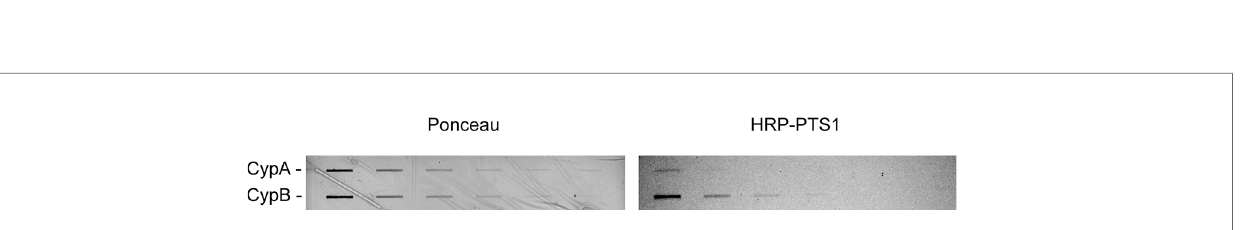
FIGURE 3 | Cyclophilin binding to PTS1. Two-fold serial dilutions of cyclophilin A (CypA) or cyclophilin B (CypB) were placed on nitrocellulose with a slot blot apparatus. Protein loading was con fi rmed by Ponceau stain (left panel). The membrane was then incubated overnight at 4°C in the presence of HRP-labeled PTS1. Chemiluminescence visualized the bound toxin (right panel). One of two representative experiments is shown. The previously established association between PTS1 and cyclophilin A (Ernst et al., 2018; Ernst et al., 2021) was barely detected in this assay, possibly because our assay used an HRP-conjugated PTS1 subunit whereas previous dot blot assays used a signal ampli fi cation strategy with primary and HRP-labeled secondary antibodies to detect the bound PTS1. Our results with HRP-conjugated PTS1 suggest the association of PTS1 with cyclophilin B is stronger than the binding of PTS1 to cyclophilin